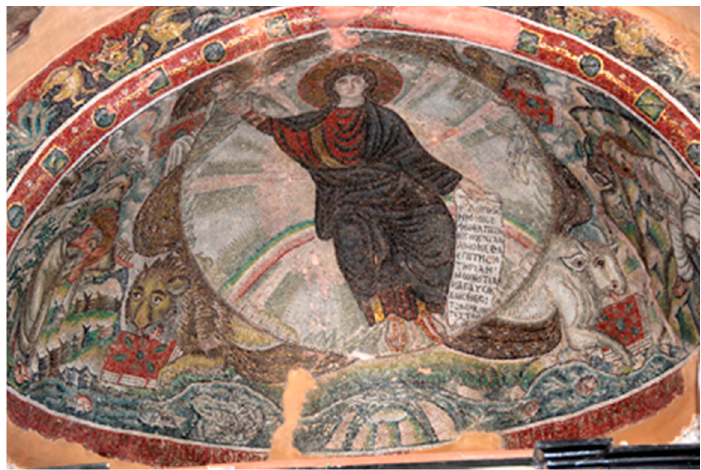
Figure 17. Thessaloniki, mosaic at Hosios David. © Manuel Castiñeiras (with kind permission)